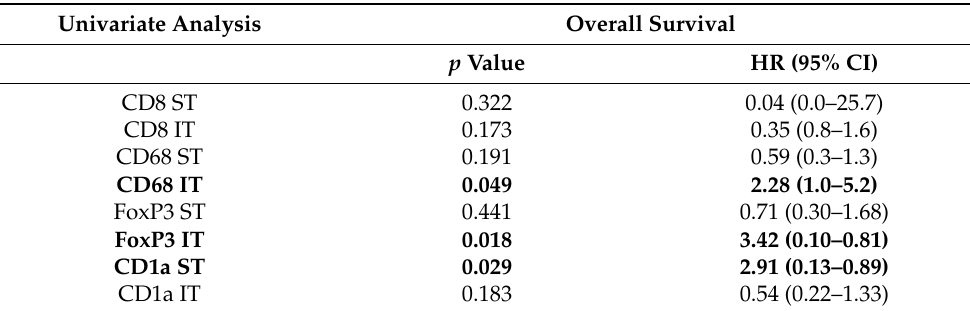
Table 3. Univariate Cox regression analysis evaluating the influence of each immune cell type and their location (ST and IT) on OS. p values < 0.05 are highlighted in bold.